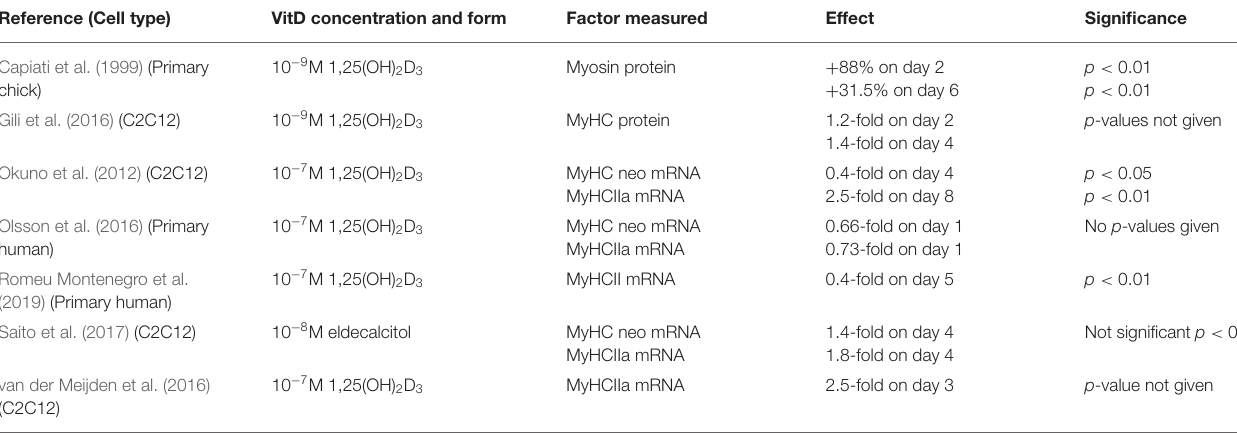
TABLE 5 | Effects of 1,25(OH) 2 D 3 or eldecalcitol on myosin or myosin heavy chain isoform expression. Reference (Cell type)